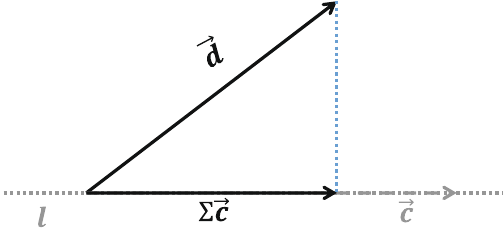
Figure 2. A geometrical interpretation of the orthogonalization